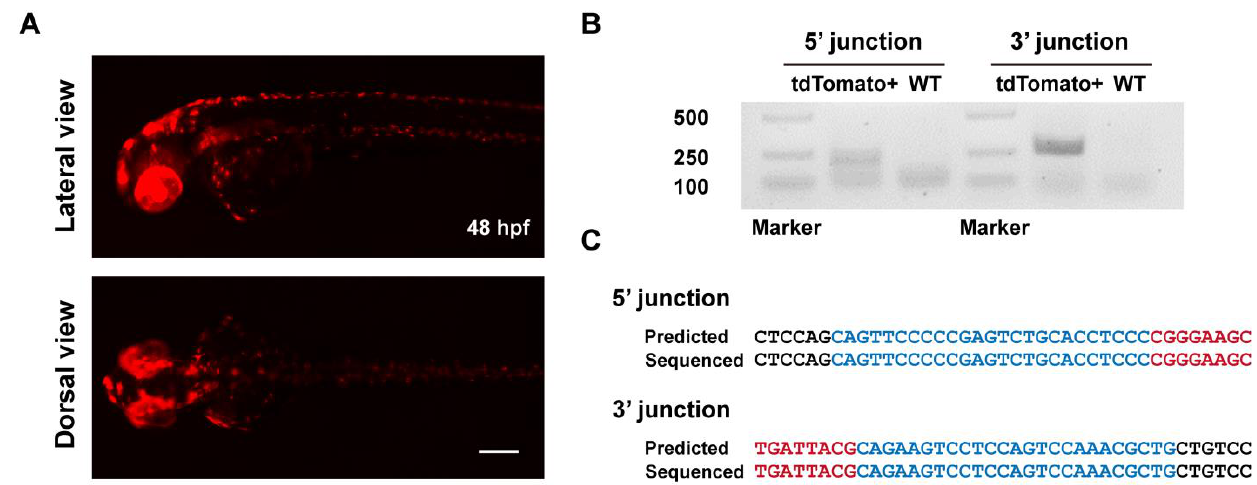
Figure 2. Evaluation of germline transmission of ErCas12a-mediated knockin with the MMEJ donor at the tyr locus. ( A ) Representative images of the red fluorescent reporter expression of F 1 embryos obtained from outcross of the three tyr MMEJ knockin-positive F 0 adults listed in Table 1. Red fluorescence can be observed in the eyes and pigment cells of the embryos. Scale bar: 200 μ m. ( B ) Junction PCR results of the tyr knockin F 1 embryos showing red fluorescence from F 0 #3. Primers tyr F1 and tdt R were used to amplify the 5’ junction, and primers bF1 and tyr R1 were used to amplify the 3’ junction. ( C ) Sequencing alignment of the junction PCR products from ( B ) after TA cloning. Black characters indicate sequence of the tyr WT allele, blue characters represent the homologous sequence designed in the donor, and red characters represent the donor sequence. Table 1. Germline transmission of ErCas12a MMEJ knockin positive F 0 adults.